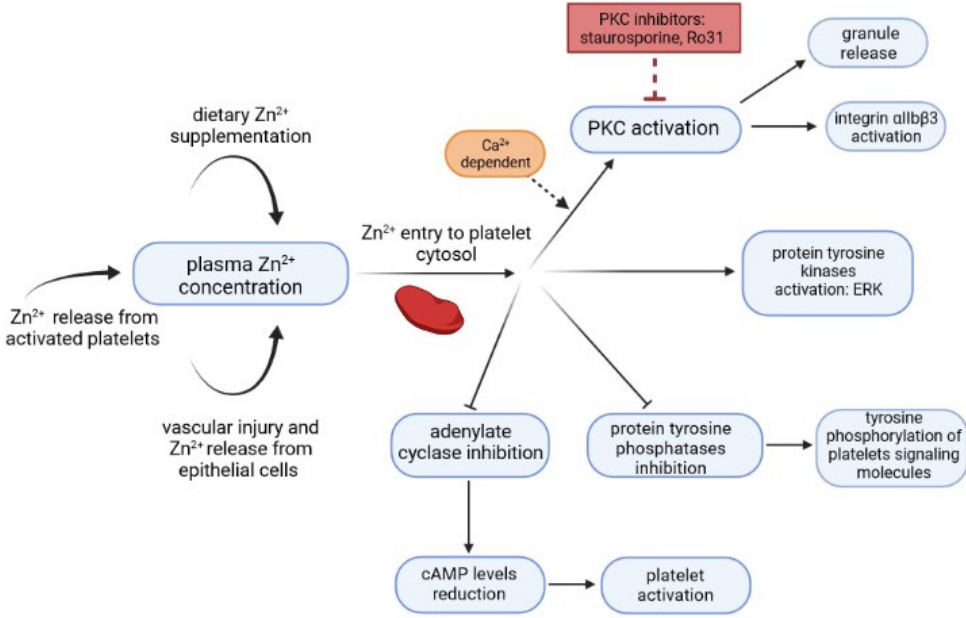
Figure 1. Diagram presenting the process of platelets activation caused by Zn 2+